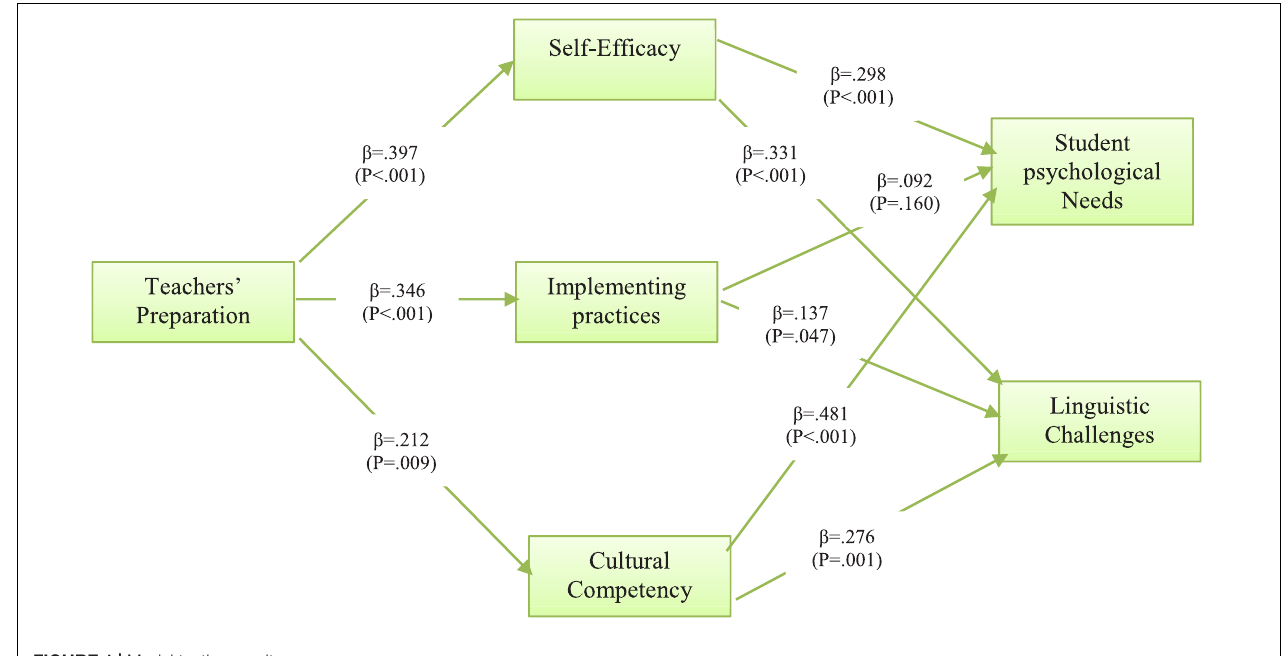
FIGURE 1 | Model testing results.